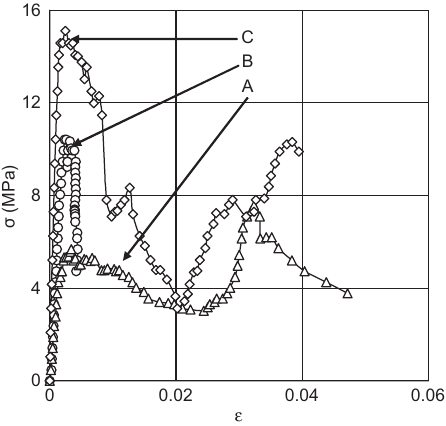
Figure 4 The infl uence of rimming on the stress-strain curve under uniaxial compression for the Kenchreae stone.